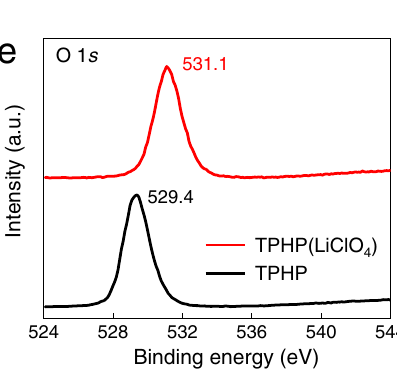
Fig. 1 | Synthesis and structure of TPHP(LiClO 4 ) polymer electrolyte. a Schematic of the synthesis process of TPHP(LiClO 4 ) (left) and photograph of the obtainedbulkTPHP(LiClO 4 )polymerelectrolyte(right).Thescalebaris1cm. b The structureofTPHP(top)andTPHP(LiClO 4 )(bottom).TheblueregionsinTPHPshow theHOMOorbitals,whichcoordinatewithLi + whenintroducingLiClO 4 . c Cl2 p